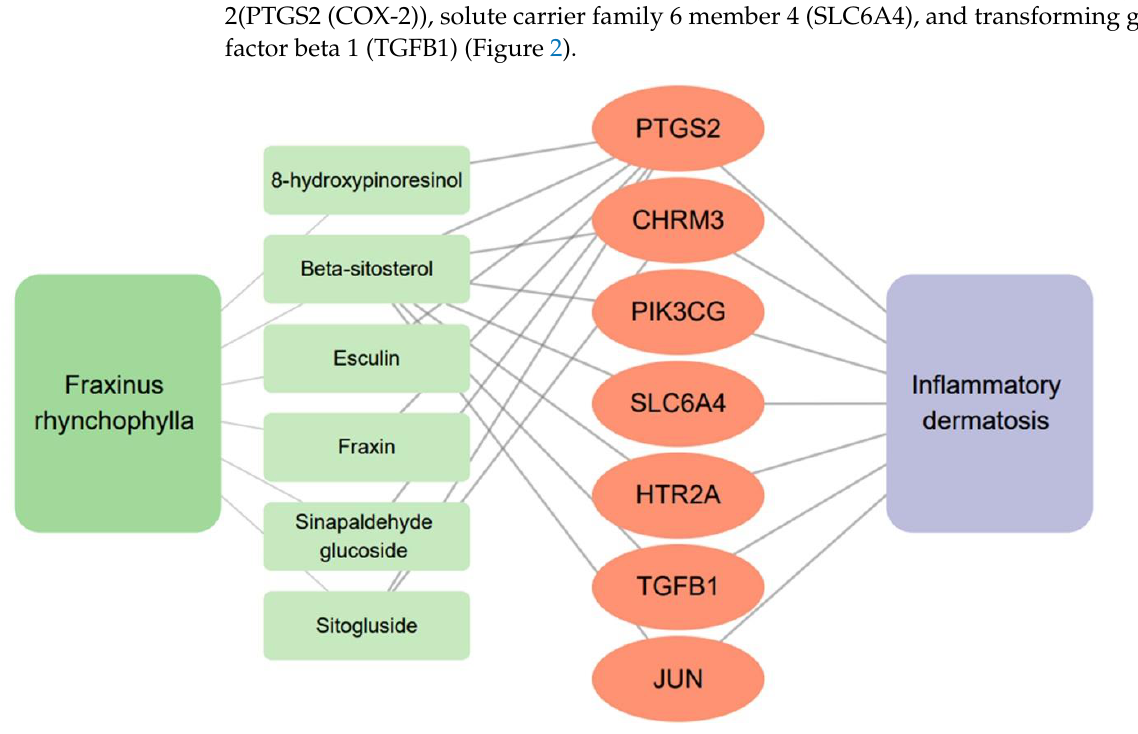
Figure 2. Six active compounds with targets associated with inflammatory dermatosis.